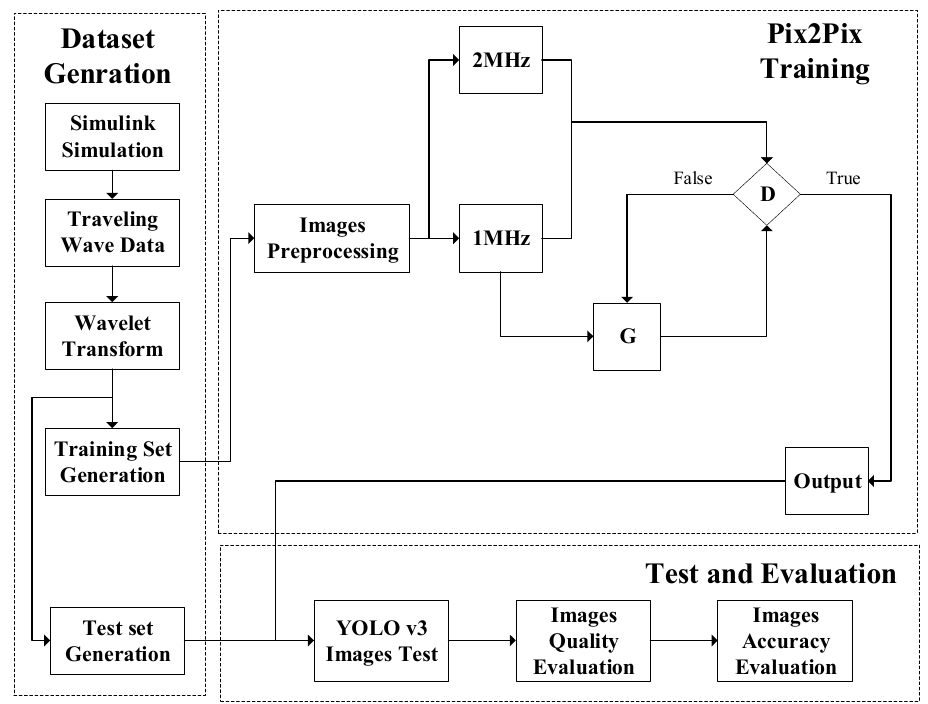
Figure 6. Flowchart of accuracy improvement method.